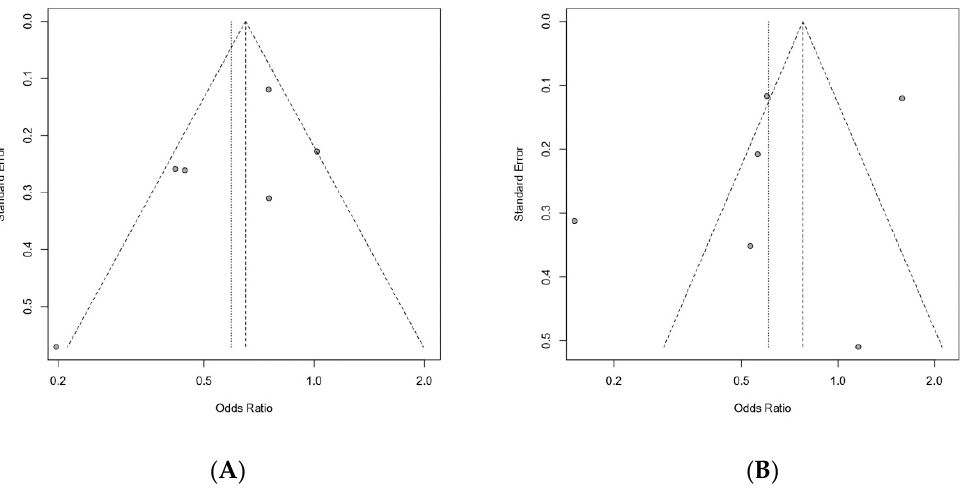
Figure 4. Graphic funnel plot of the included studies. ( A ) Pneumonia, ( B ) Mortality.